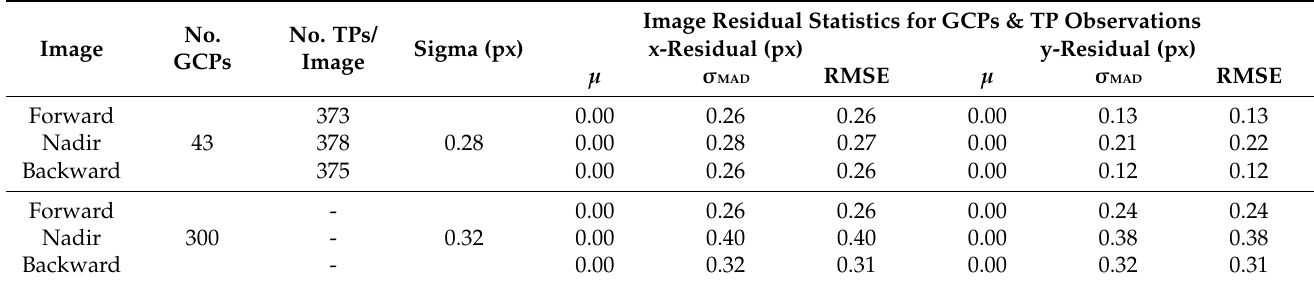
Table 2. Pléiades tri-stereo satellite imagery aerial triangulation results.